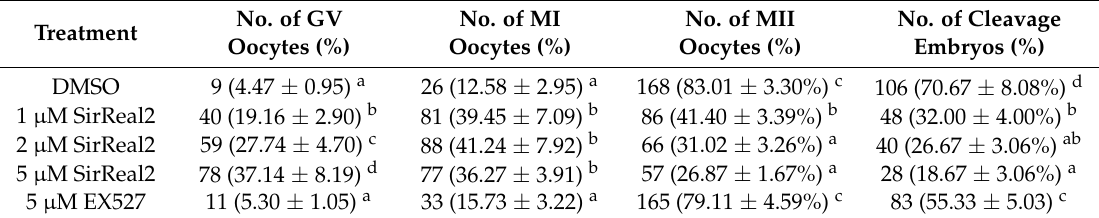
Table 1. The effects of SirReal2 or EX527 on oocyte maturation and development. No. of Treatment